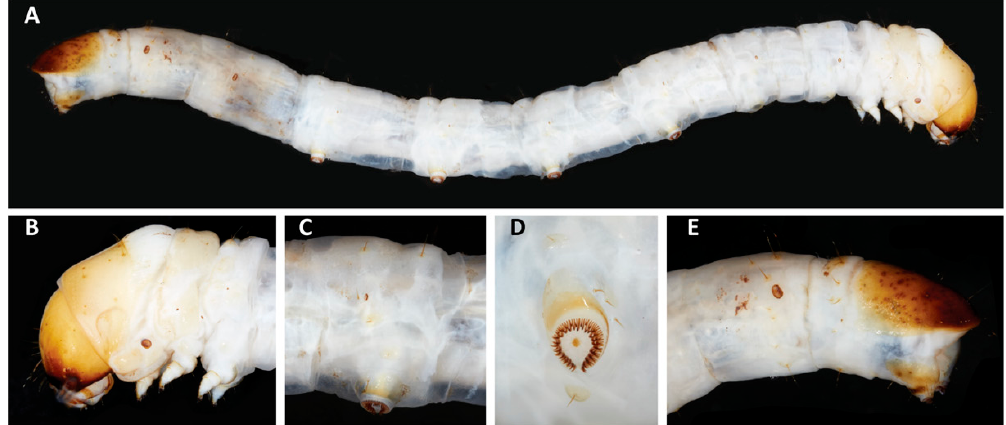
Figure 6. Larva. ( A ) Full side view of Casmara subagronoma larva; ( B ) lateral view of larval head and mouth parts; ( C ) lateral view third abdominal segment; ( D ) ventral view of planta and crochets